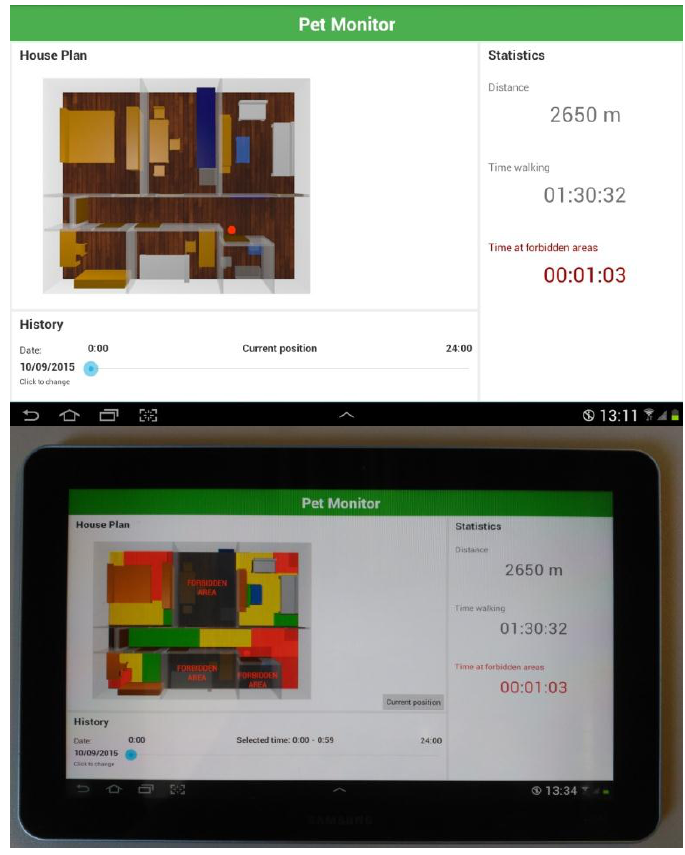
Figure 12. Implemented android based application for the dog monitoring inside a home.